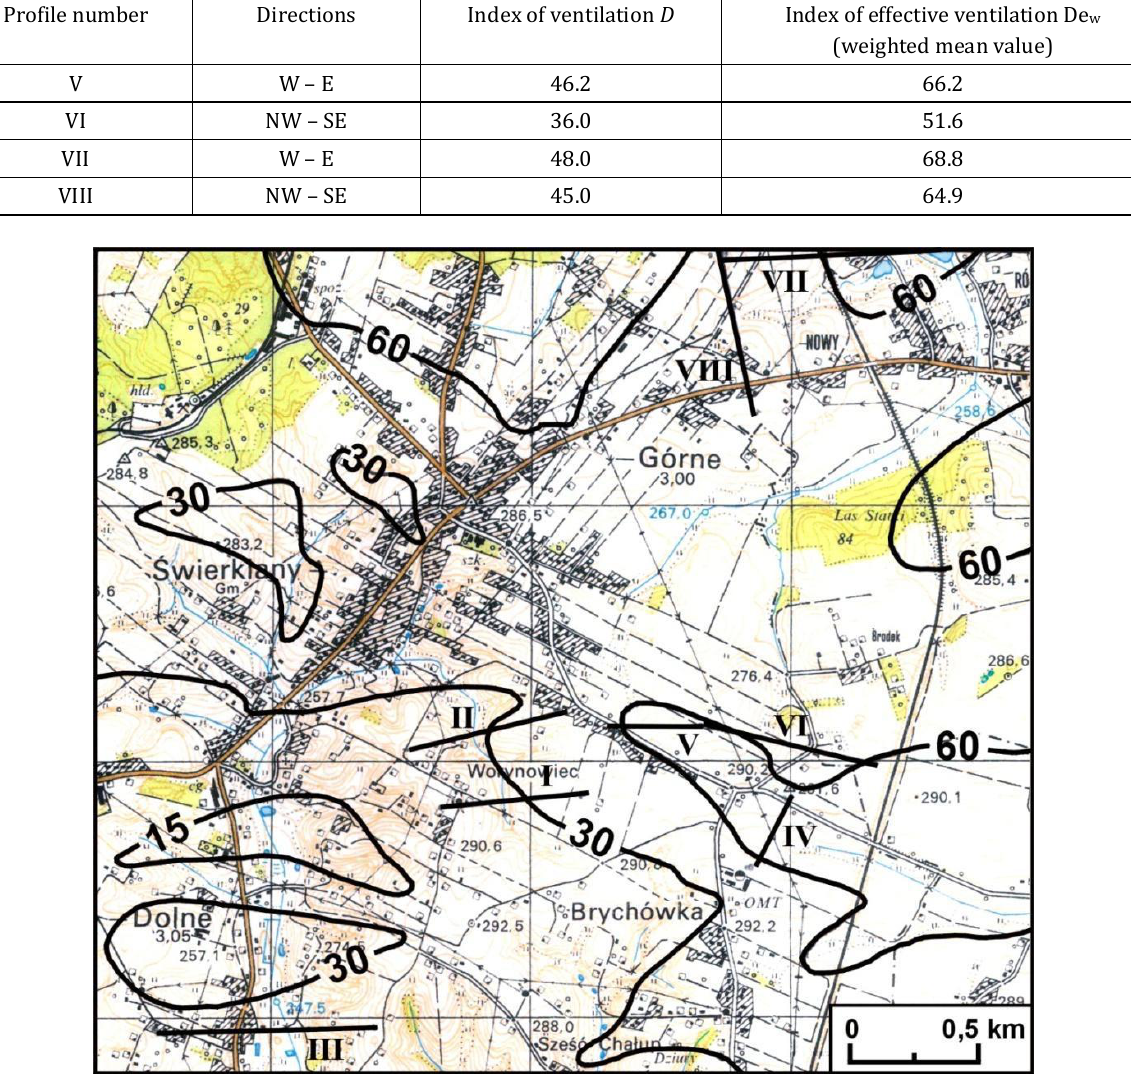
Fig. 3. The spatial distribution of the average value of the index of effective ventilation De w in the vicinity of Jastrzębie Zdrój; I – profiles, 60 – values of the De